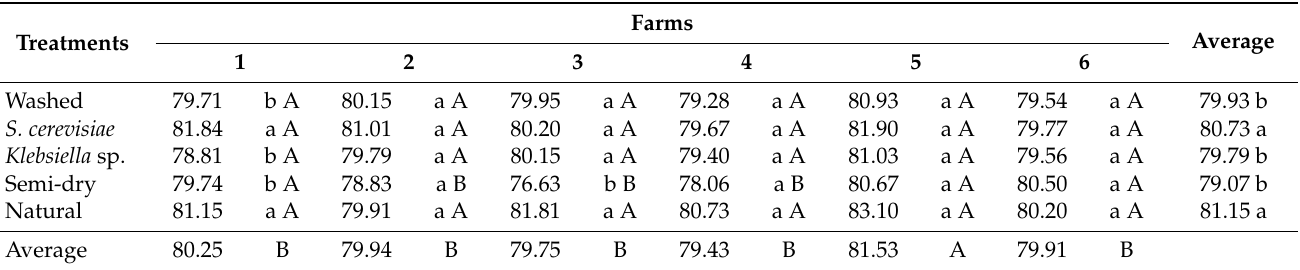
Table 2. Means of the final characteristic score evaluated in five treatments of CConilon ( Coffea canephora ) and in six